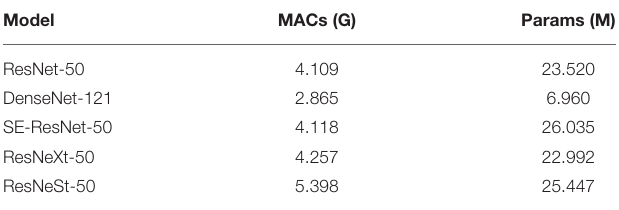
TABLE 1 | Parameters of the